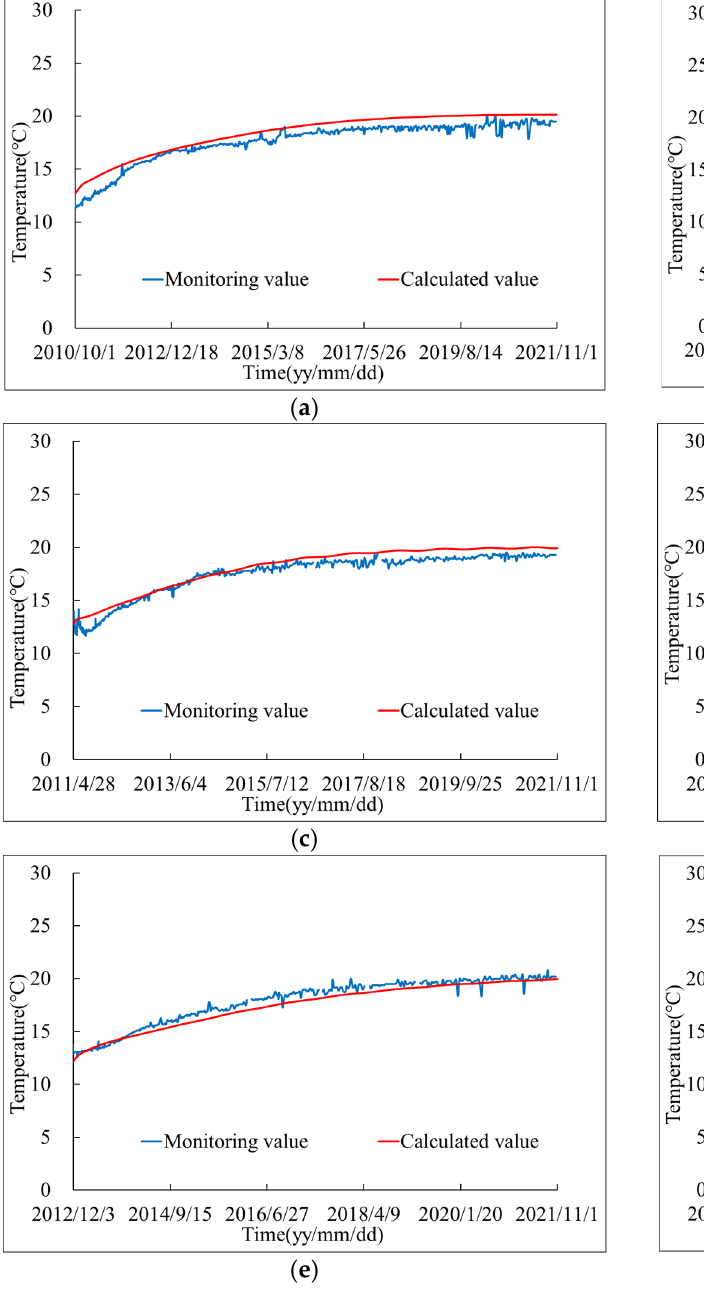
Figure 12. Comparison between measured value and calculated value of temperature at measuring points inside the dam. ( a ) J15-11 (358 m, Area A); ( b ) J15-41 (523.7 m, Area A); ( c ) J15-20 (403 m, Area B); ( d ) J15-32 (463 m, Area B); ( e ) J9-29 (523.7 m, Area C); ( f ) J15-32 (580.7 m, Area C).